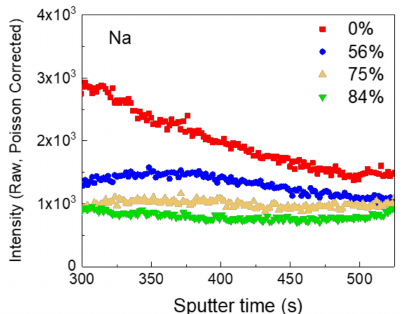
Figure 3. TOF-SIMS depth-profile of Na in the CZTSSe layer parts in the solar cell device, was coated with di ff erent passivation